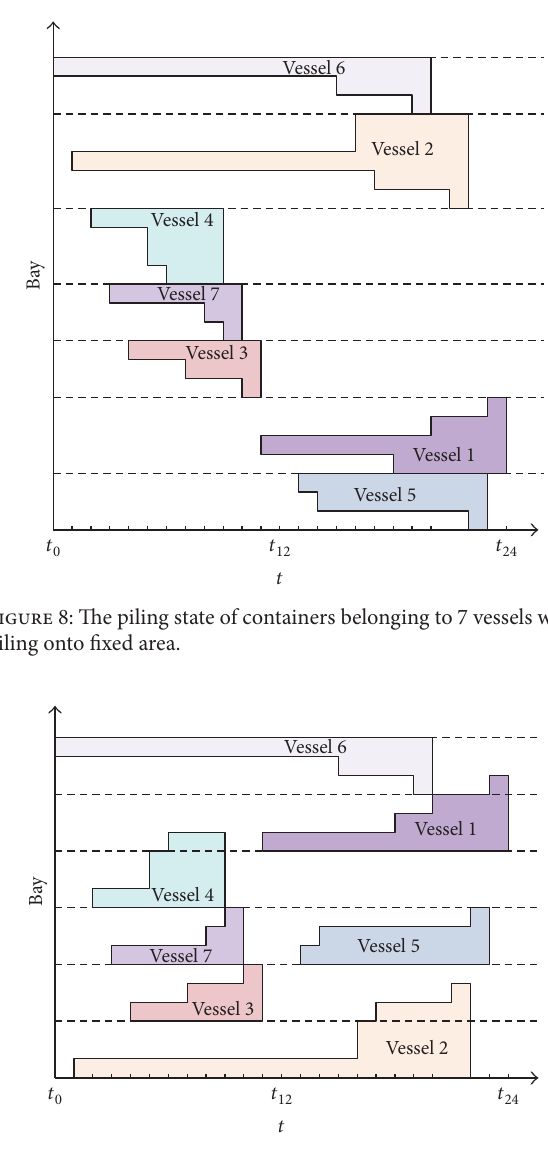
Figure 9: The piling state of containers belonging to 7 vessels when piling onto fixed and shared area. Table 3: Overlapping amounts and relocation movements of three stacks from first train.